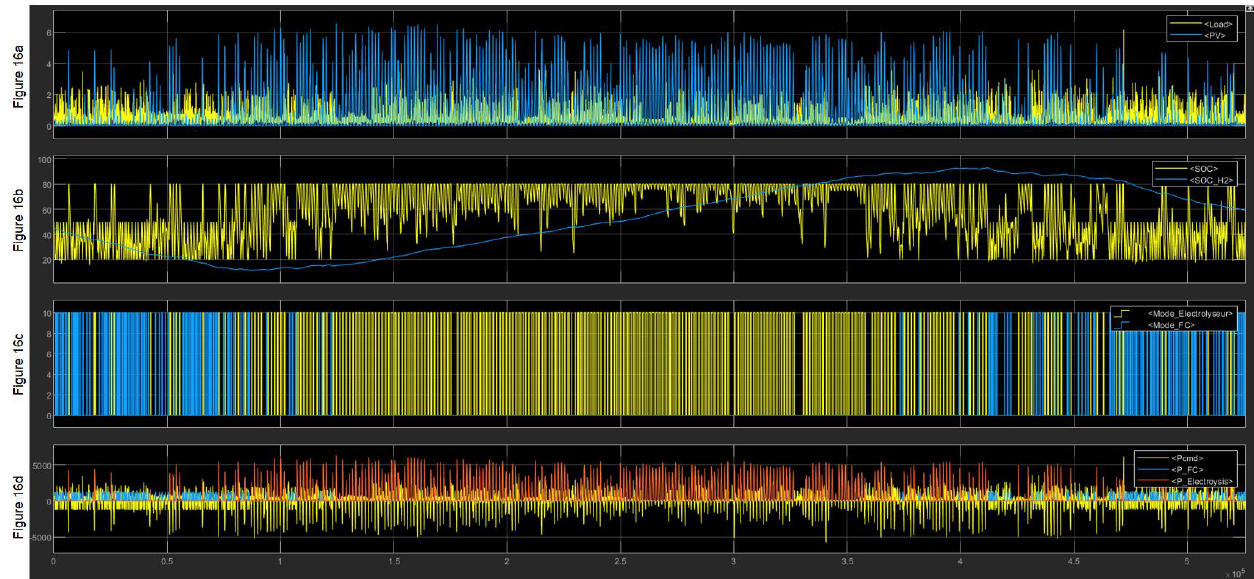
Figure 16. Different curves recorded by simulation of one year using Simulink model (first diagram (top ( a )): PV power (blue) and overall load (yellow); second diagram ( b ): SoC of Li-ion battery (yellow) and SoC of hydrogen storage (blue); third diagram ( c ): electrolyser turned on (yellow) and fuel cell turned on (blue); fourth diagram (bottom ( d )): energy provided by the fuel cell (blue), energy used by the electrolyser (orange) and energy flow towards the Li-ion battery (negative value) and energy supplied by the Li-ion battery (positive value) (yellow), respectively. ( x -Axis: data points (1 data point for every minute within 1 year =̂ 525600 data points)).